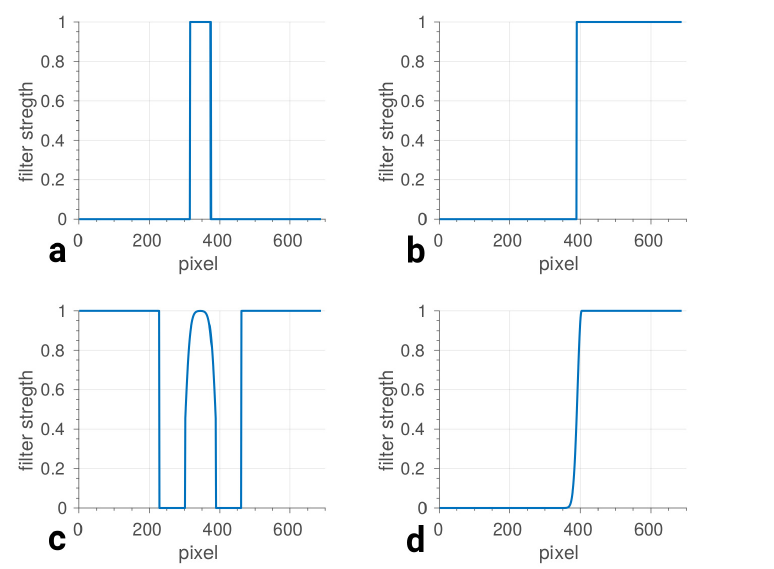
Figure 5. Sharp rectangular frequency filter to select the 0th harmonic ( a ) and 1st harmonic ( b ). Gaussian shaped filter to select the 0th harmonic ( c ) and 1st harmonic ( d